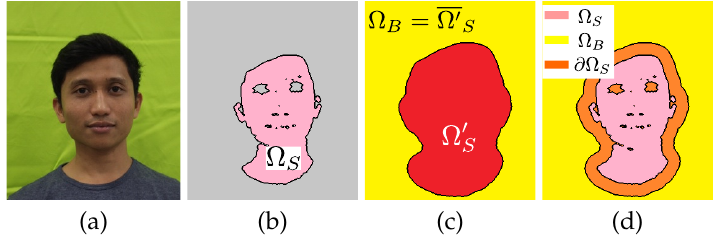
Figure 3. Region example. ( a ) input image; ( b ) skin color region Ω S , ( c ) dilated skin color region Ω (cid:48) and ( d ) each region in the whole image. Pink, red, yellow, and orange indicate each region Ω S , Ω (cid:48) Ω Ω B , and ∂ S ,